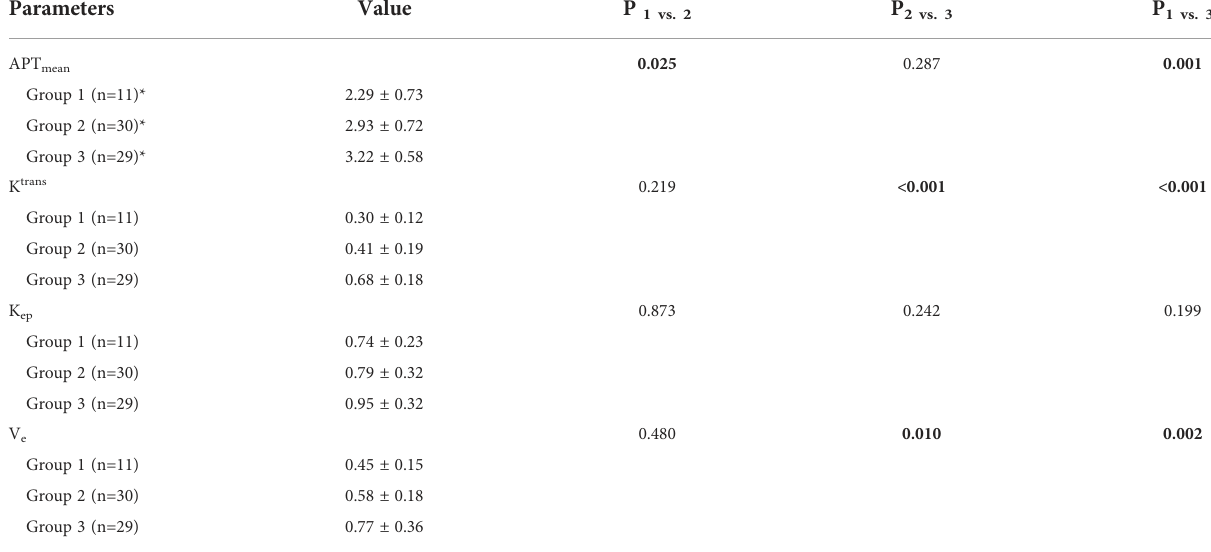
TABLE 6 Comparison of imaging parameters among the three groups.